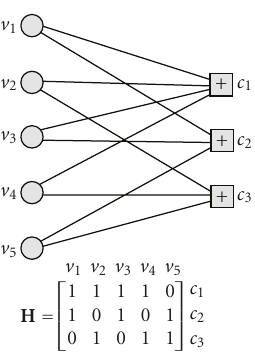
Figure 1: The two representations of LDPC codes: graph form and matrix